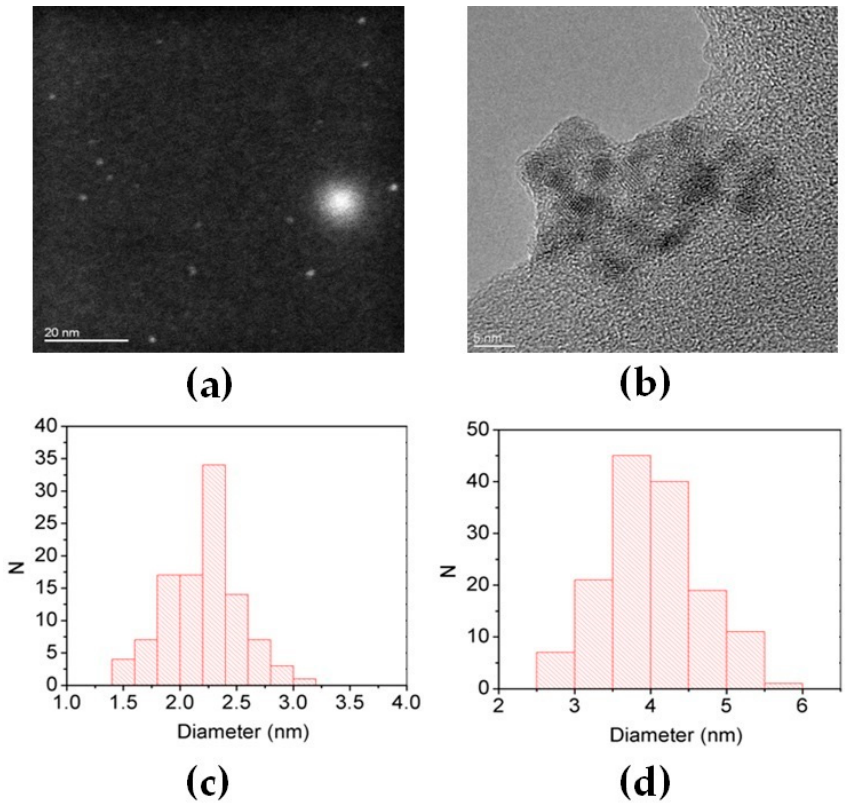
Figure 9. Images obtained by ( a ) HAADF-STEM and ( b ) phase contrast HRTEM for green and red QDs produced using as time of reaction of 4 and 30 min, respectively. Distribution of the number of particles (N) as a function of the diameter of the particles for ( c ) green and ( d ) red QDs. As regards the red CdTe QDs synthesized using a reaction time of 30 min, the HRTEM images exhibit a diameter of 4 nm with a standard deviation of 0.65 nm estimated on a number of 144 QDs (Figure 9b,d). It is possible to assume an average diameter of d = 4.0 ± 0.2